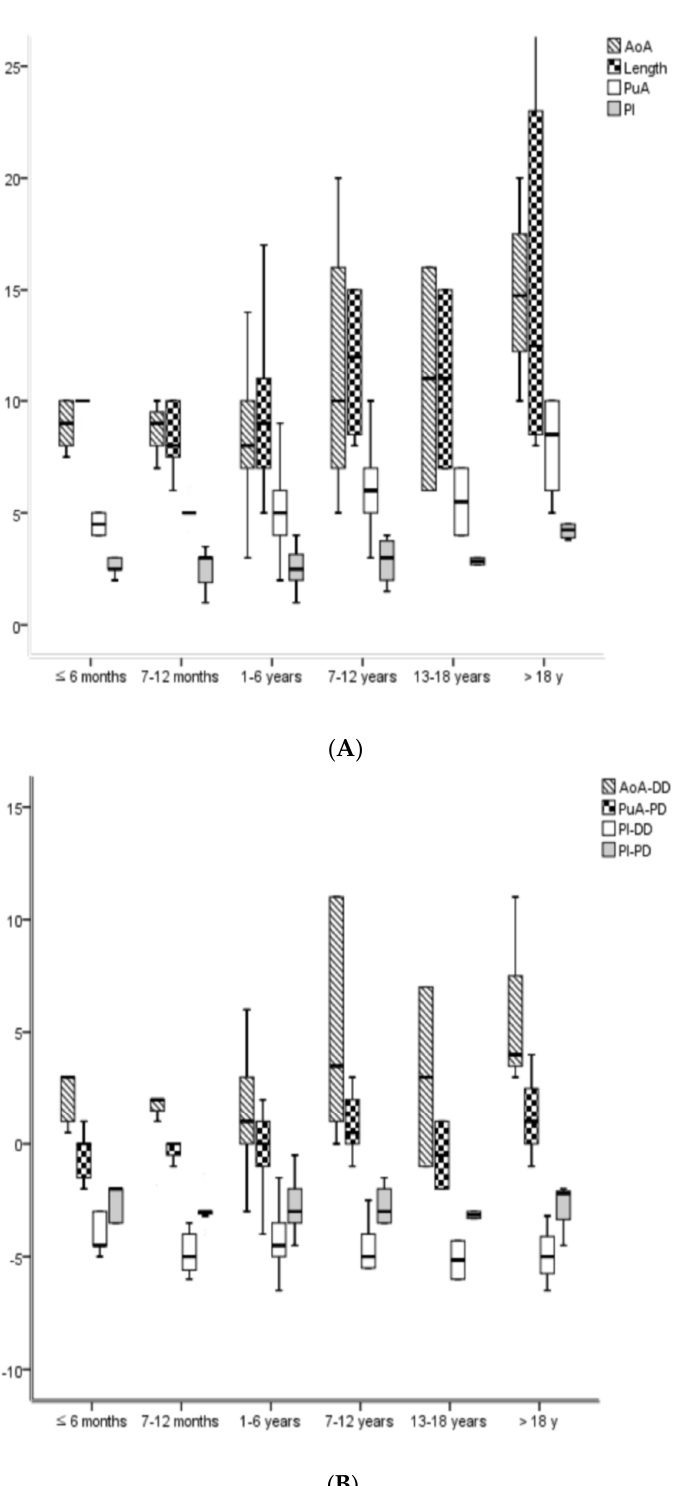
Figure 1. The changes in PDA sizes ( A ) and size gaps between PDA and NOC ( B ) according the chronological age groups. Ao, aorta; AoA, aortic ampulla of PDA; NOC, Nit ‐ Occlud ® coil; PDA, patent ductus arteriosus; PuA, pulmonary ampulla of PDA; PI, PDA isthmus; DD, distal diameter of NOC; PD, proximal diameter of NOC.